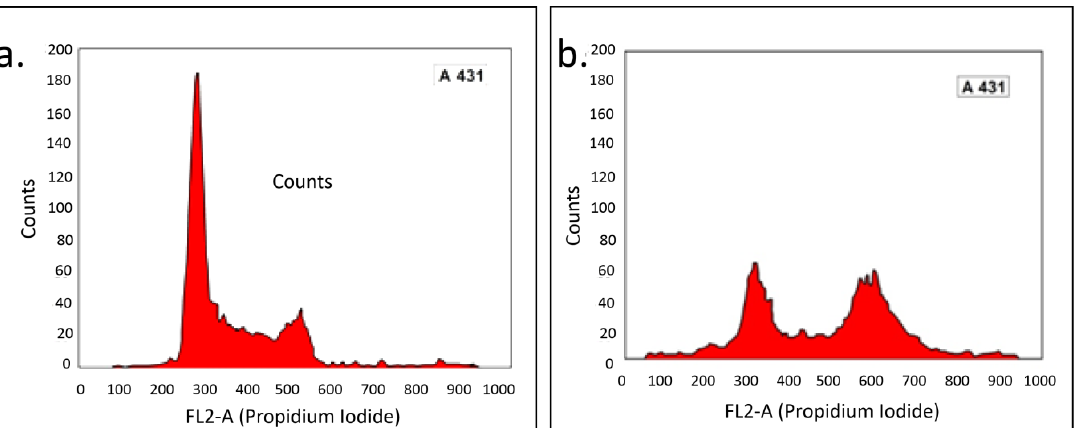
Figure 10. Cell cycle analysis of PTAgNPs in response to the A431 cells by flow cytometry.( a ) Control;( b ) treated.